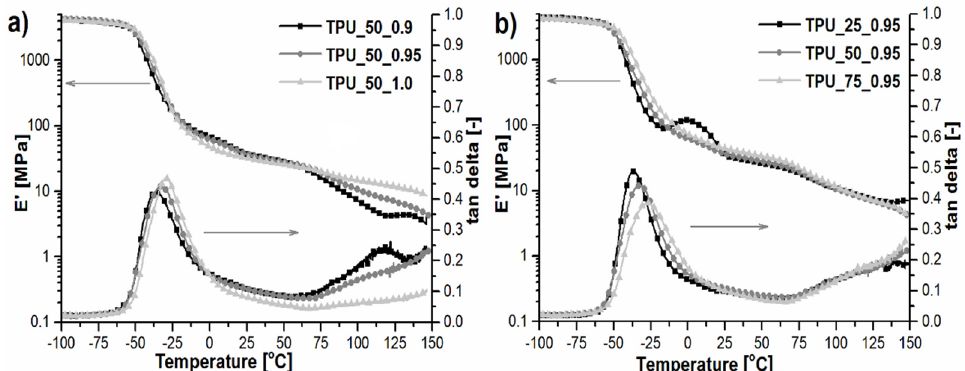
Figure 6. The storage modulus (E’) and tangent delta (tan δ ) as a function of temperature for TPUs synthesized by using a different [NCO]/[OH] molar ratios and by using an equal amount of both prepolymers (based on PO3G1000 and PO3G2700) ( a ), and for TPUs synthesized by using the same [NCO]/[OH] molar ratio and ( b ) different amounts of both prepolymers (based on PO3G1000 and